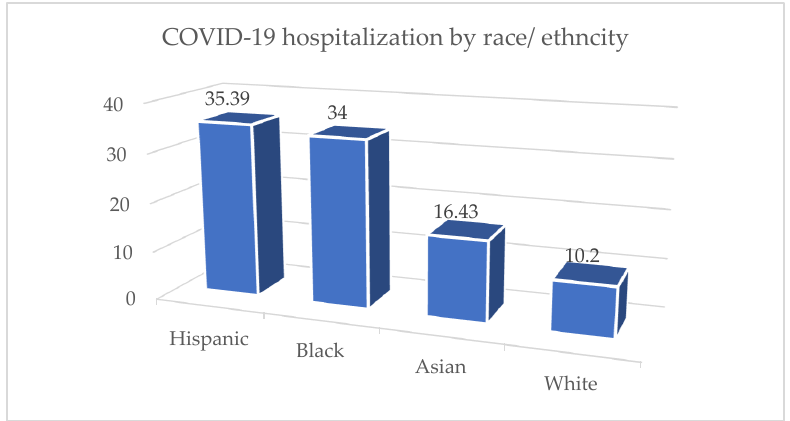
Figure 4. COVID ‐ 19 hospitalization by race and ethnicity. Figure 4. COVID-19 hospitalization by race and